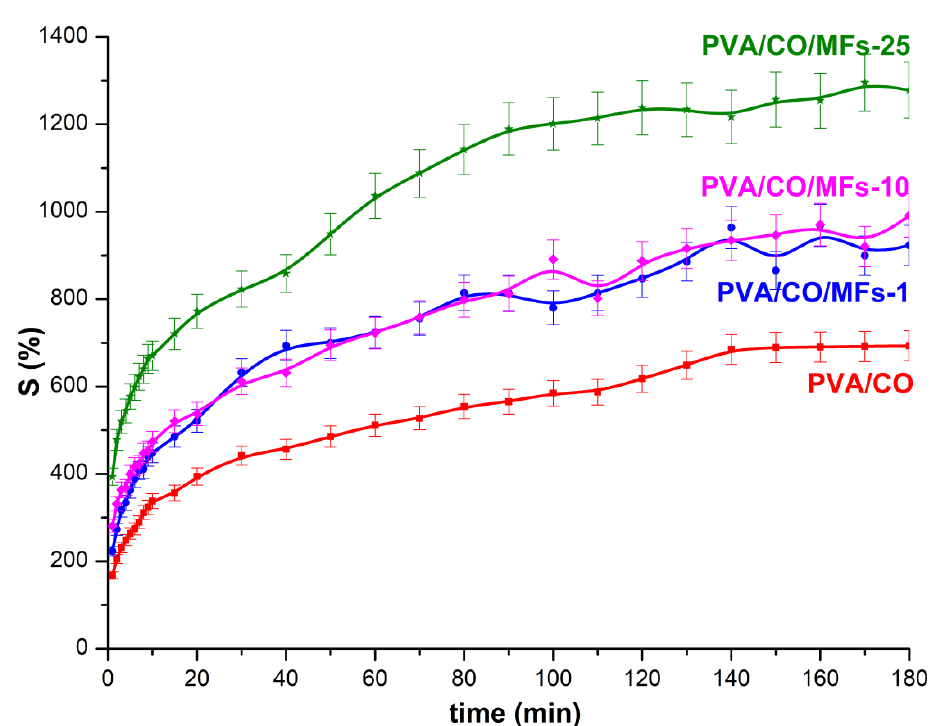
Figure 7. Degree of swelling of hydrogels in water.